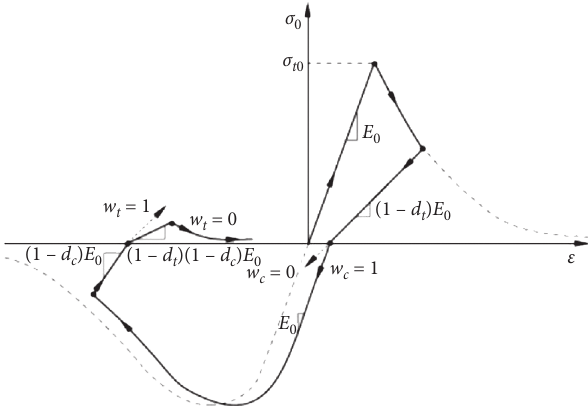
Figure 3: Uniaxial load cycle assuming default values for the stiffness recovery factors ( w t � 0 and w c � 1)